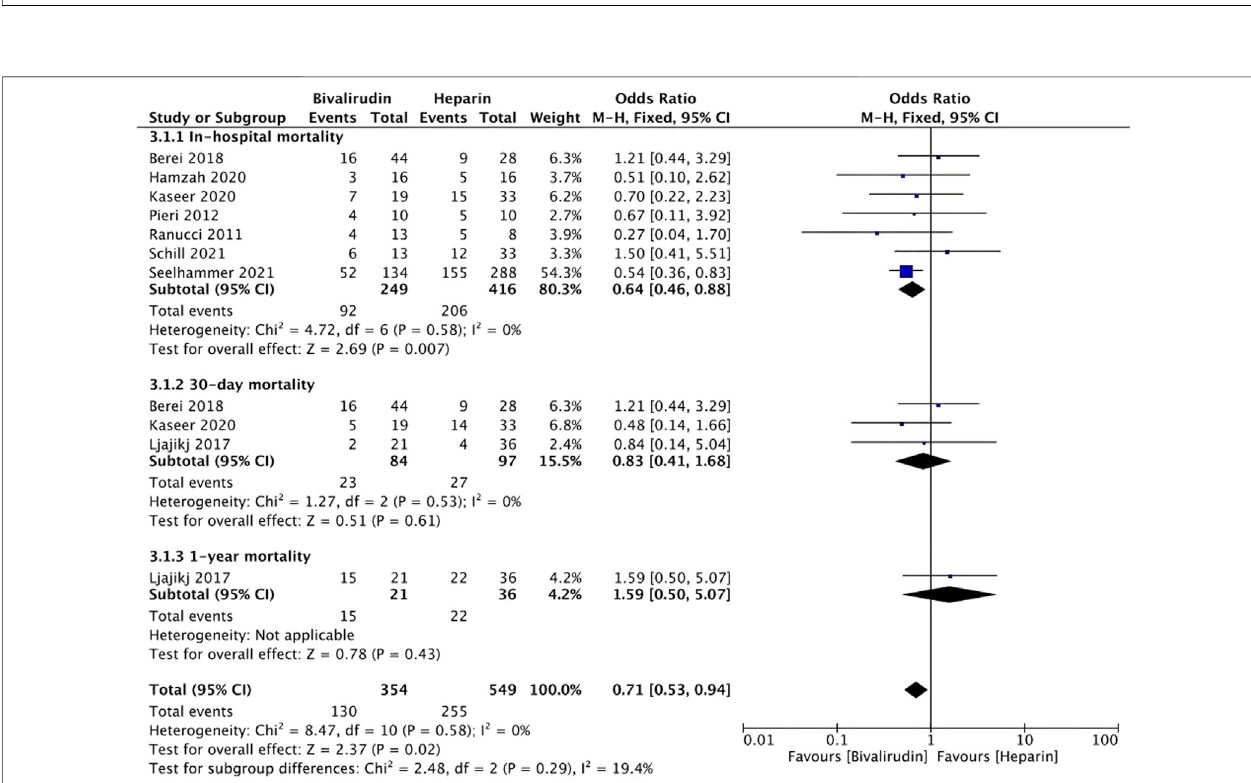
FIGURE 4 | The incidence of mortality between the bivalirudin group and the heparin group.